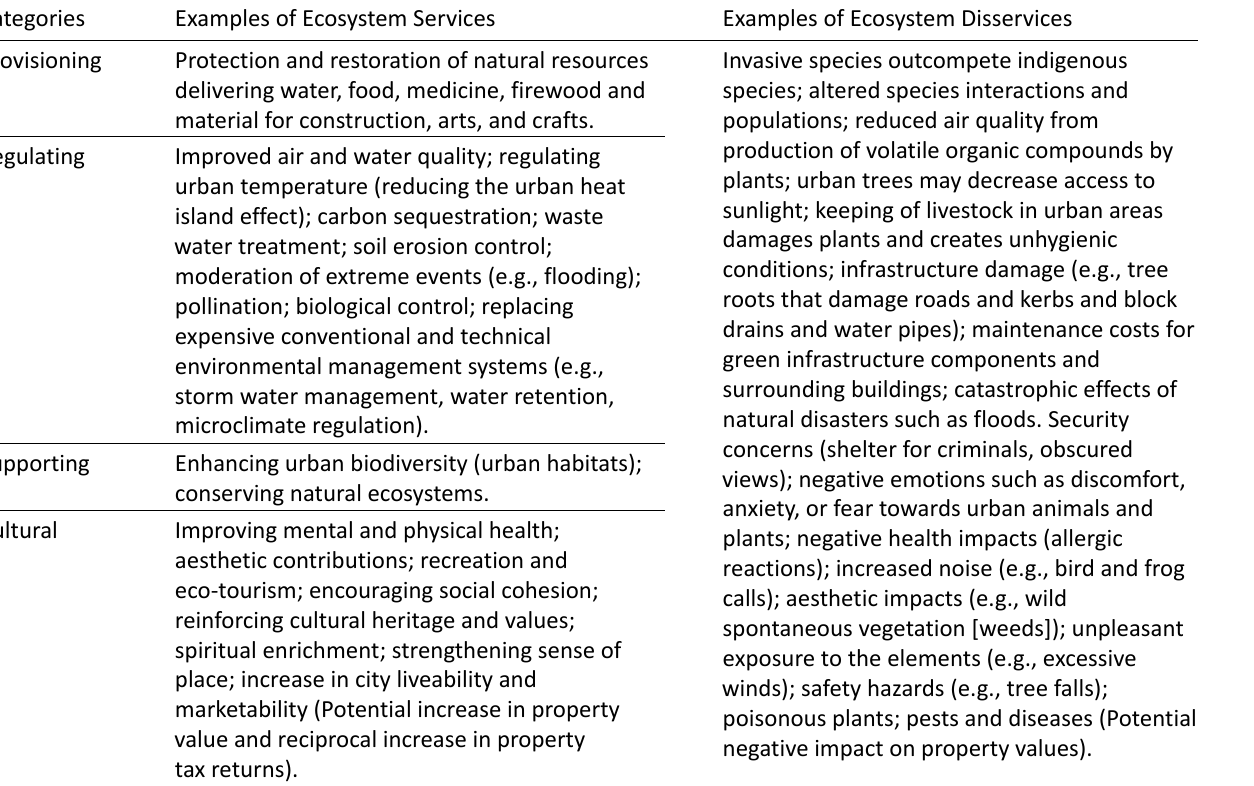
Table 1. Summary of UGS ecosystem services and